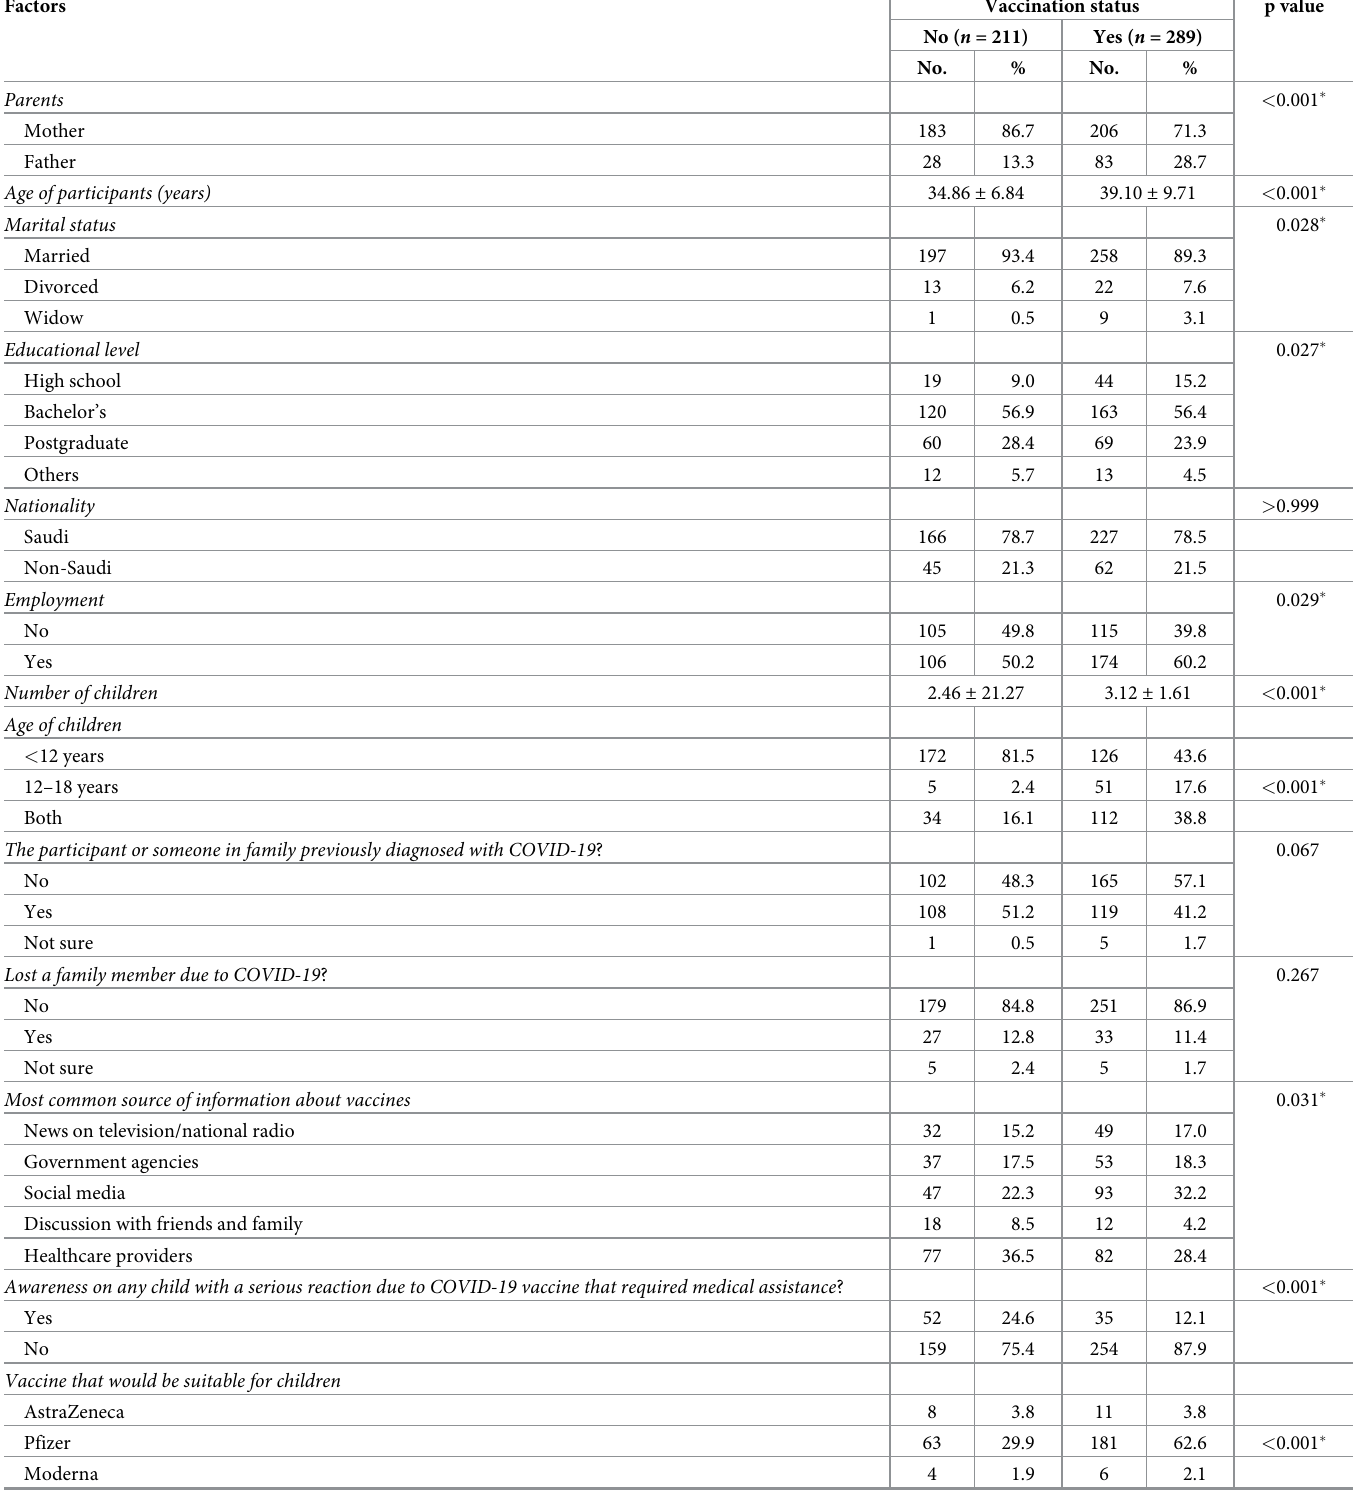
Table 4. Factors affecting vaccination of children against COVID-19 ( n =